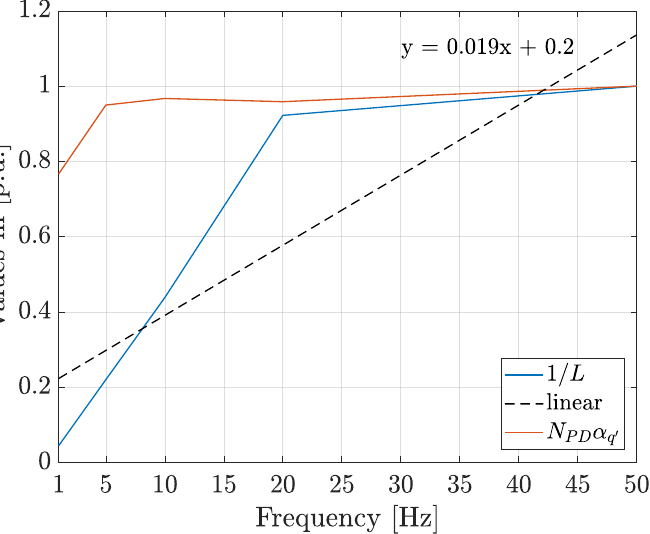
Figure 8. Comparison of the accumulated damage and ageing rate function, N PD α q’ , for different voltage frequencies.